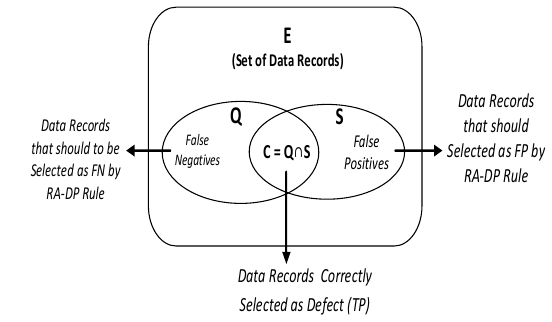
Fig.3: DP Confusion Matrix